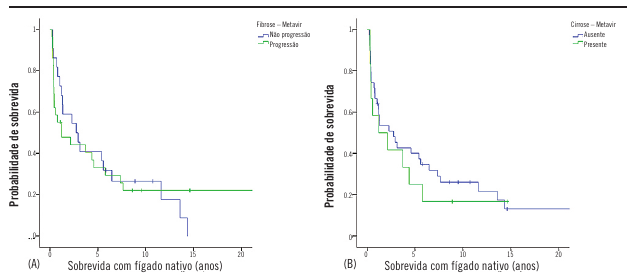
figura 1 – Progressão ou não progressão da fibrose, avaliada segundo o escore Metavir, e presença ou ausência de cirrose no momento da